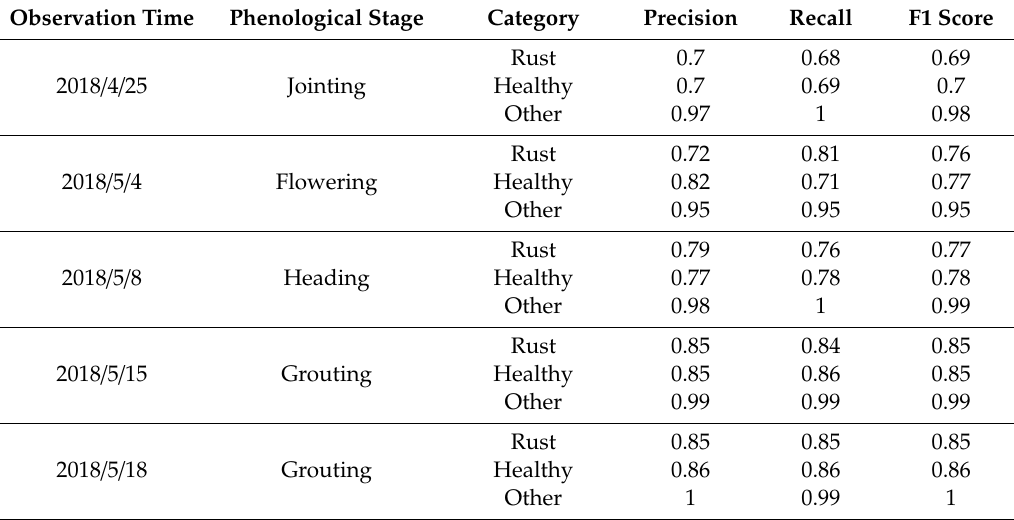
Table 1. The performance of the proposed model at di ff erent observation times across the wheat growing